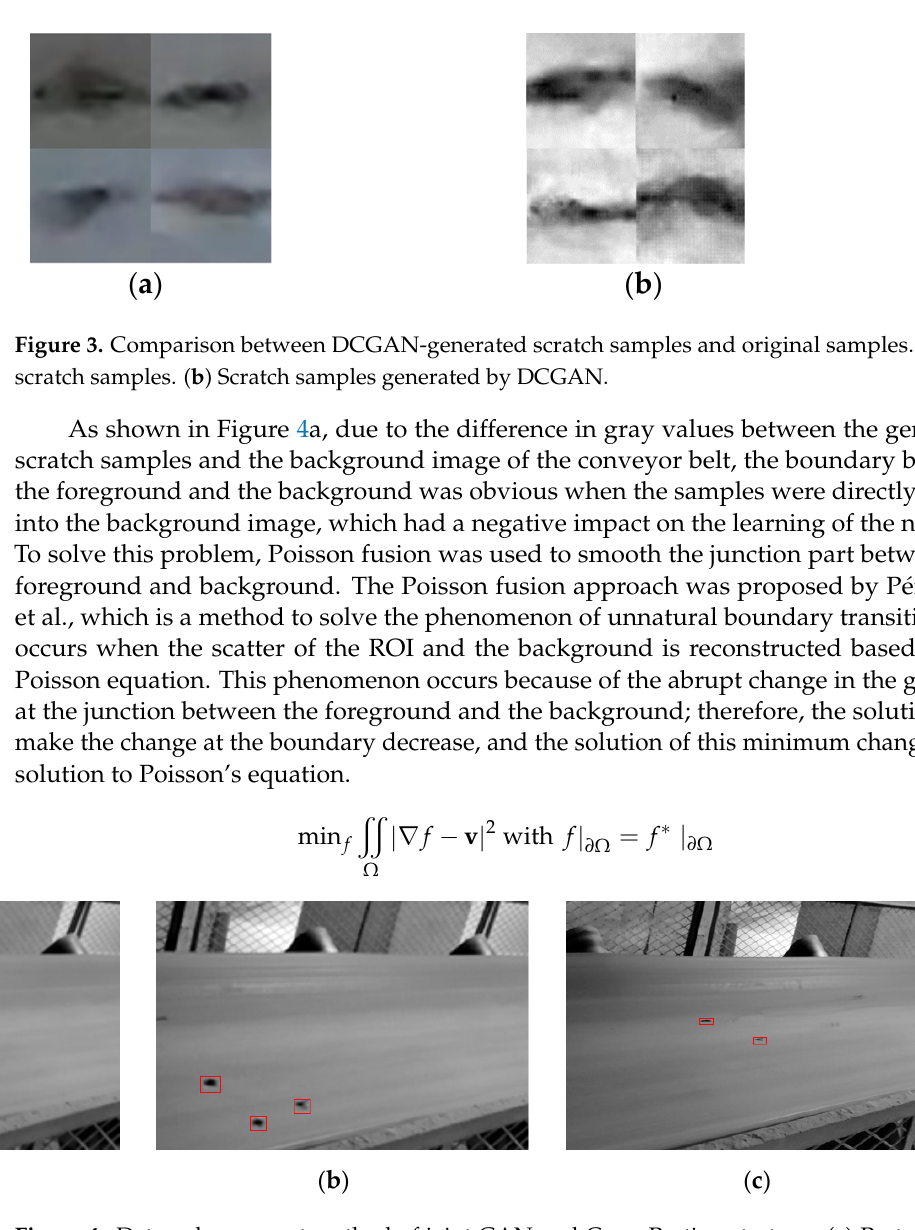
Figure 4. Data enhancement method of joint GAN and Copy-Pasting strategy. ( a ) Paste directly. ( b ) Poisson fusion. ( c ) Poisson fusion + random scale zooming.